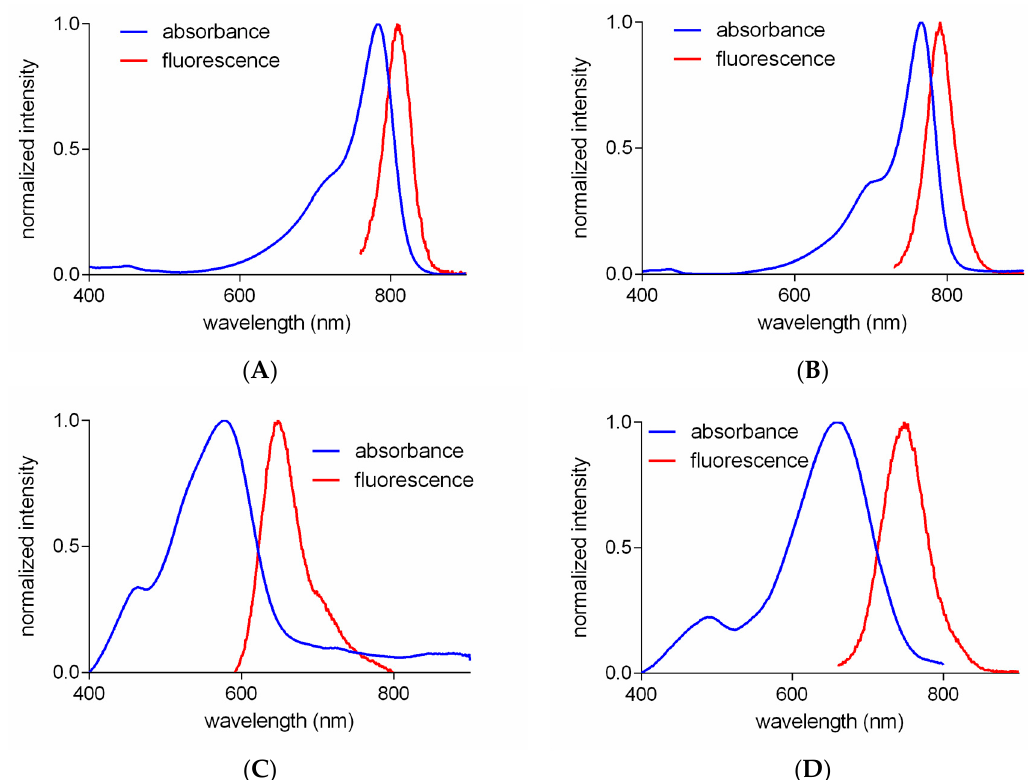
Figure 2. Normalized absorbance and fluorescence of compounds 1a – d (6 µM, 37 °C) in pH 7.24 10 mM PBS buffer. ( A ) compound 1a : λ max abs 783 nm (blue), λ max emiss 809 nm (red). ( B ) compound 1b : λ max abs 766 nm (blue), λ max emiss 791 nm (red). ( C ) compound 1c : λ max abs 578 nm (blue), λ max emiss 648 nm (red). ( D ) compound 1d : λ max abs 658 nm (blue), λ max emiss 748 nm (red).